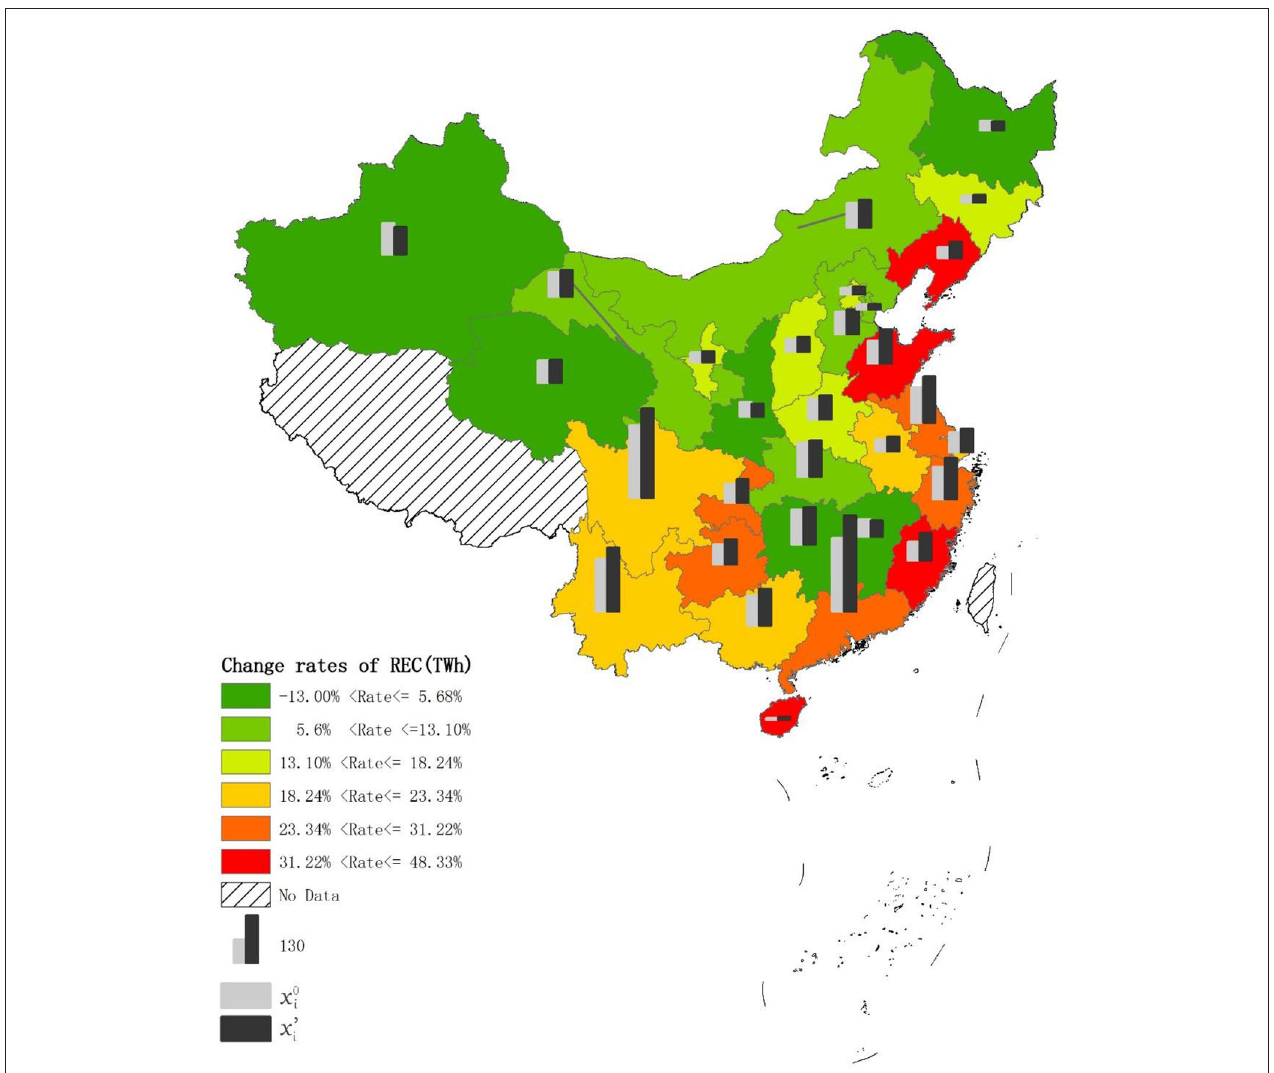
FIGURE 8 | Geographical distribution of provincial REC through reallocation. All the provinces are marked on the basis of the increase rate from x 0 i to x i ′ . Tibet, Taiwan, Hong Kong, and Macau are not displayed due to the lack of